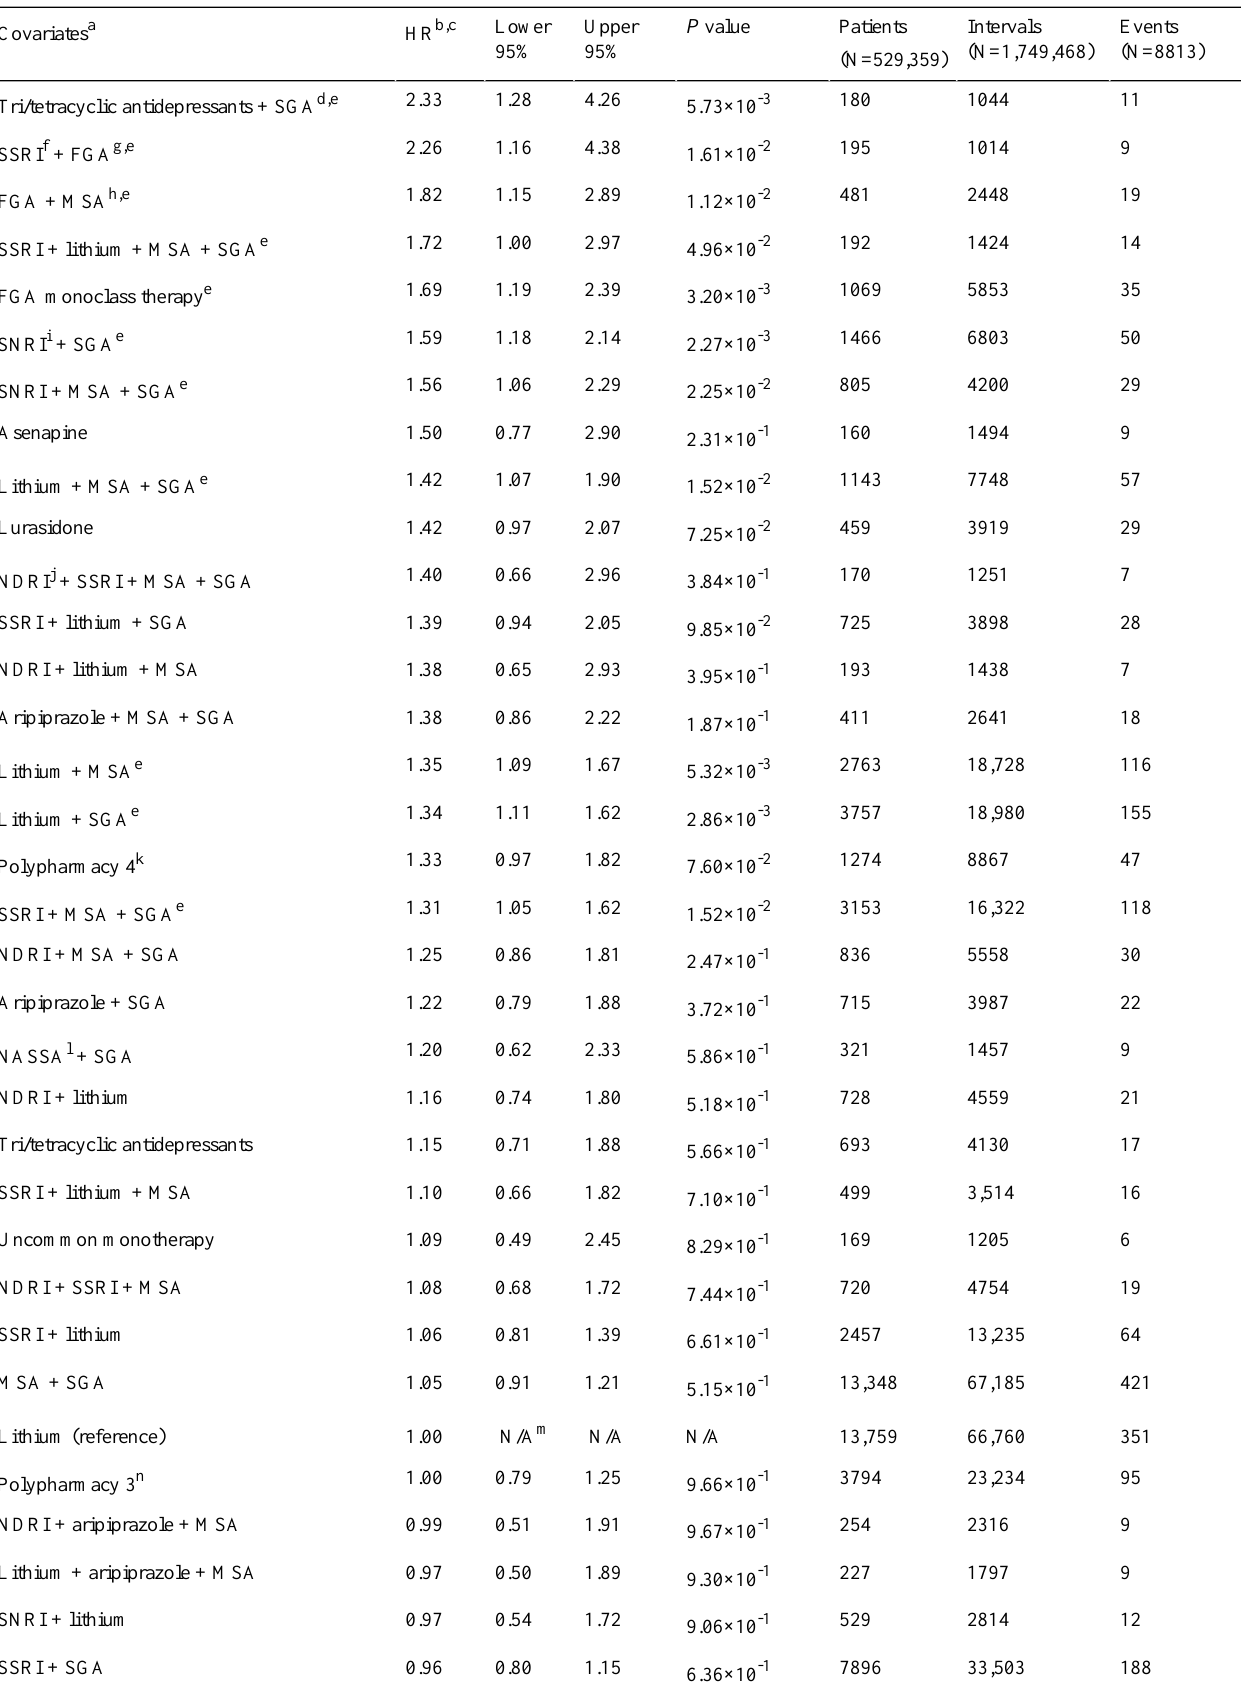
Table 1. Cox regression model comparing 64 pharmacotherapies and “no drug” to lithium for the risk of subsequent coded and/or imputed self-harm in patients with bipolar disorder of all